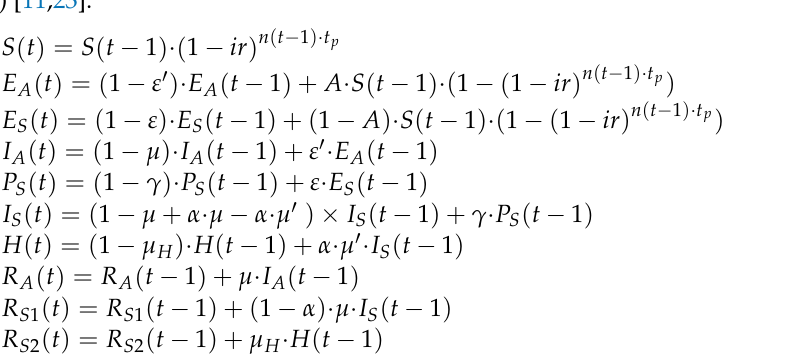
Figure 1. The improved SEIR model considering both close contact behaviors and susceptibility. In the simulation, the time step was set to 1 day. On the t th day after the appearance of the first confirmed case ( I A and I S ), the dynamics of COVID-19 transmission are listed